Question: Name the type of graph shown.
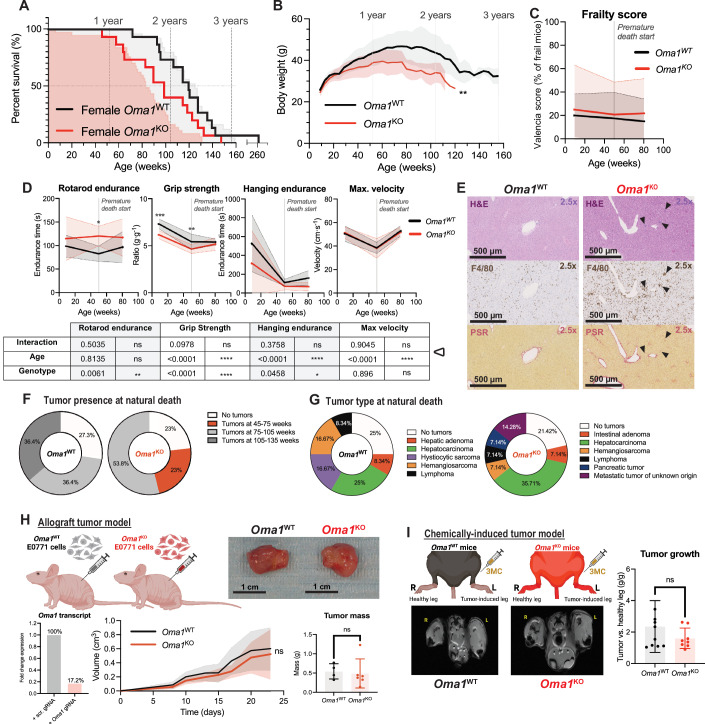
Answer: line